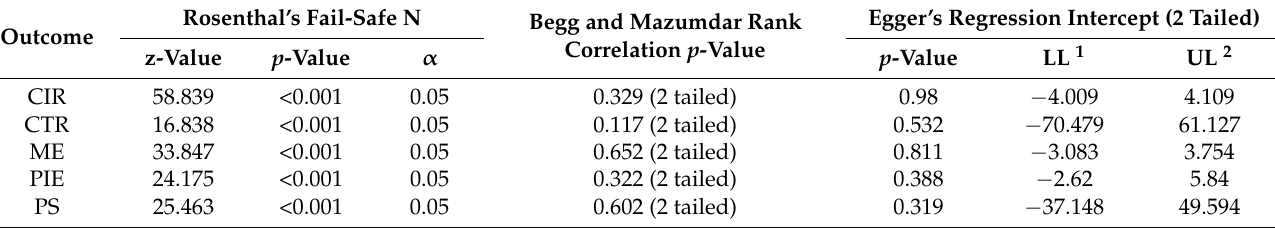
Table 2. The publication bias test of 5